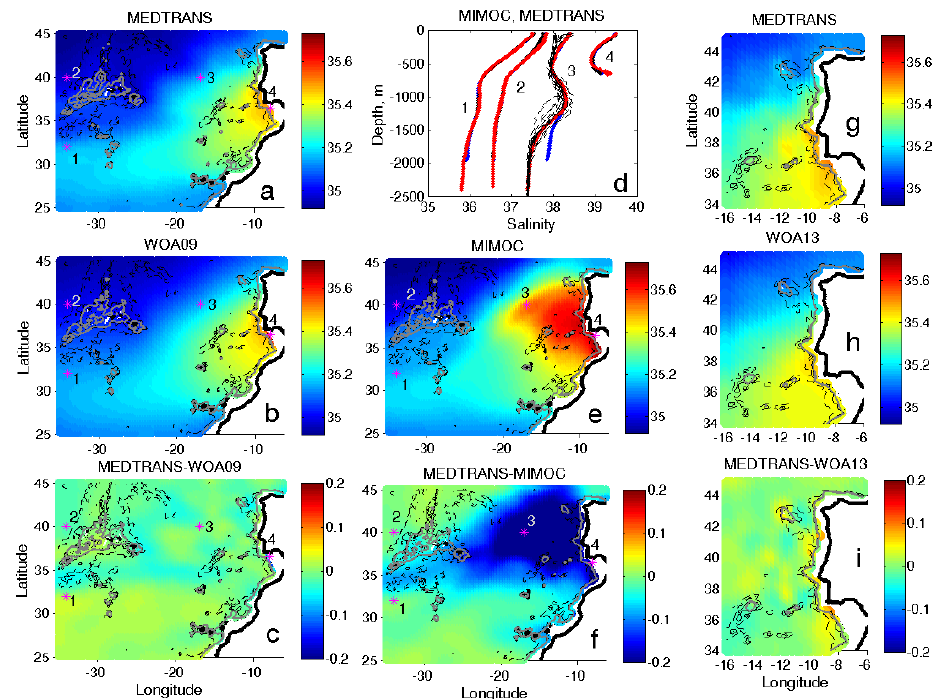
Figure 9. Salinity at 1700m; (a) and (g) MEDTRANS, (b) WOA09, (c) MEDTRANS minus WOA09, (e) MIMOC, (f) MEDTRANS minus MIMOC, (h) WOA13, and (i) MEDTRANS minus WOA13. Plate (d) presents vertical profiles of MEDTRANS (red) and MIMOC (blue) at points 1 (32 ◦ N, 34 ◦ W), 2 (40 ◦ N, 34 ◦ W), 3 (40 ◦ N, 17 ◦ W), and 4 (37 ◦ N, 8 ◦ W). WOA13 profiles (black) are not seen since they are nearly identical to MEDTRANS profiles for points 1–3 and to the MIMOC profile for point 4. Dashed lines over climatic profile 3 are the observed CTD casts within a 10km distance from this